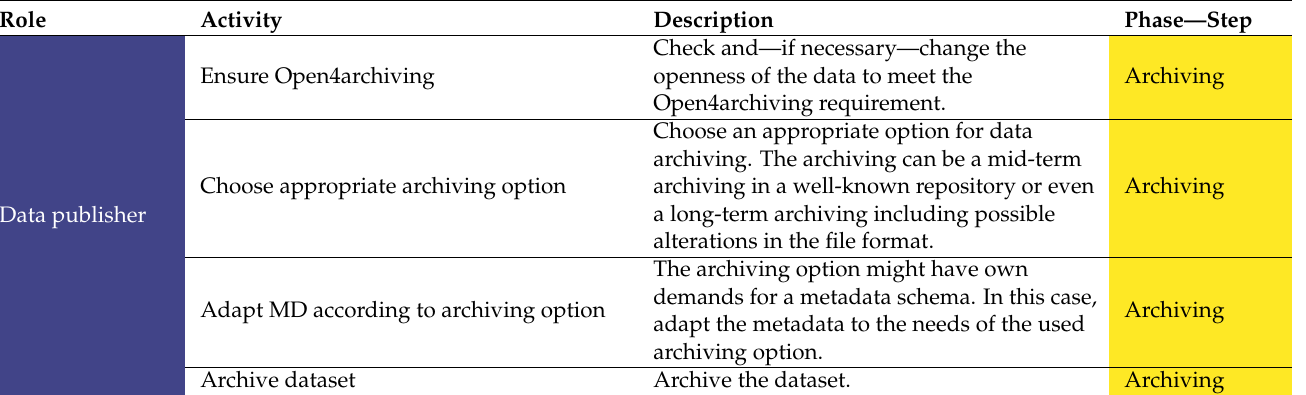
Table 14. Roles and their activities with descriptions at archiving